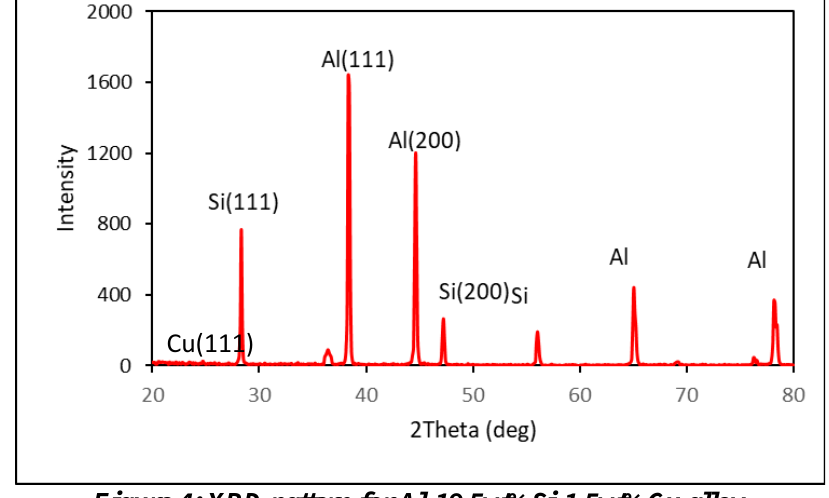
Figure 4: XRD pattern for Al-19.5wt%Si-1.5wt%Cu alloy.